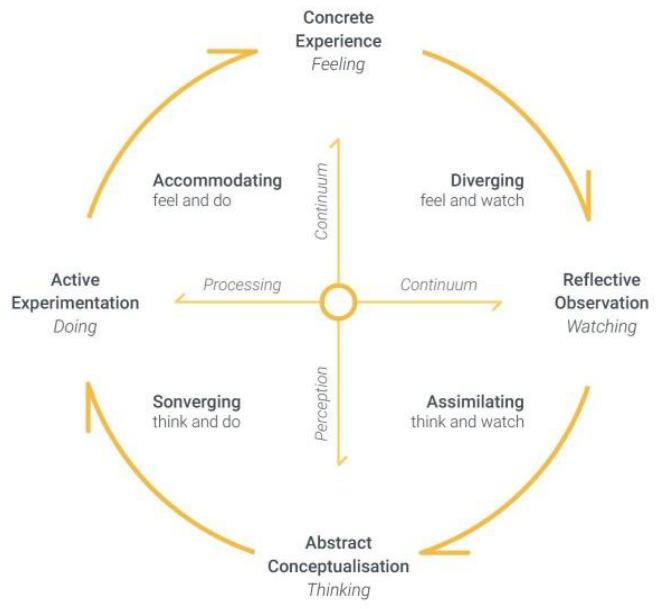
Figure 13. Elaboration of the experiential model of Kolb and Freitas (Source: Arnab S. et al., 2015. Mapping learning and game mechanics for serious games analysis, 2015).